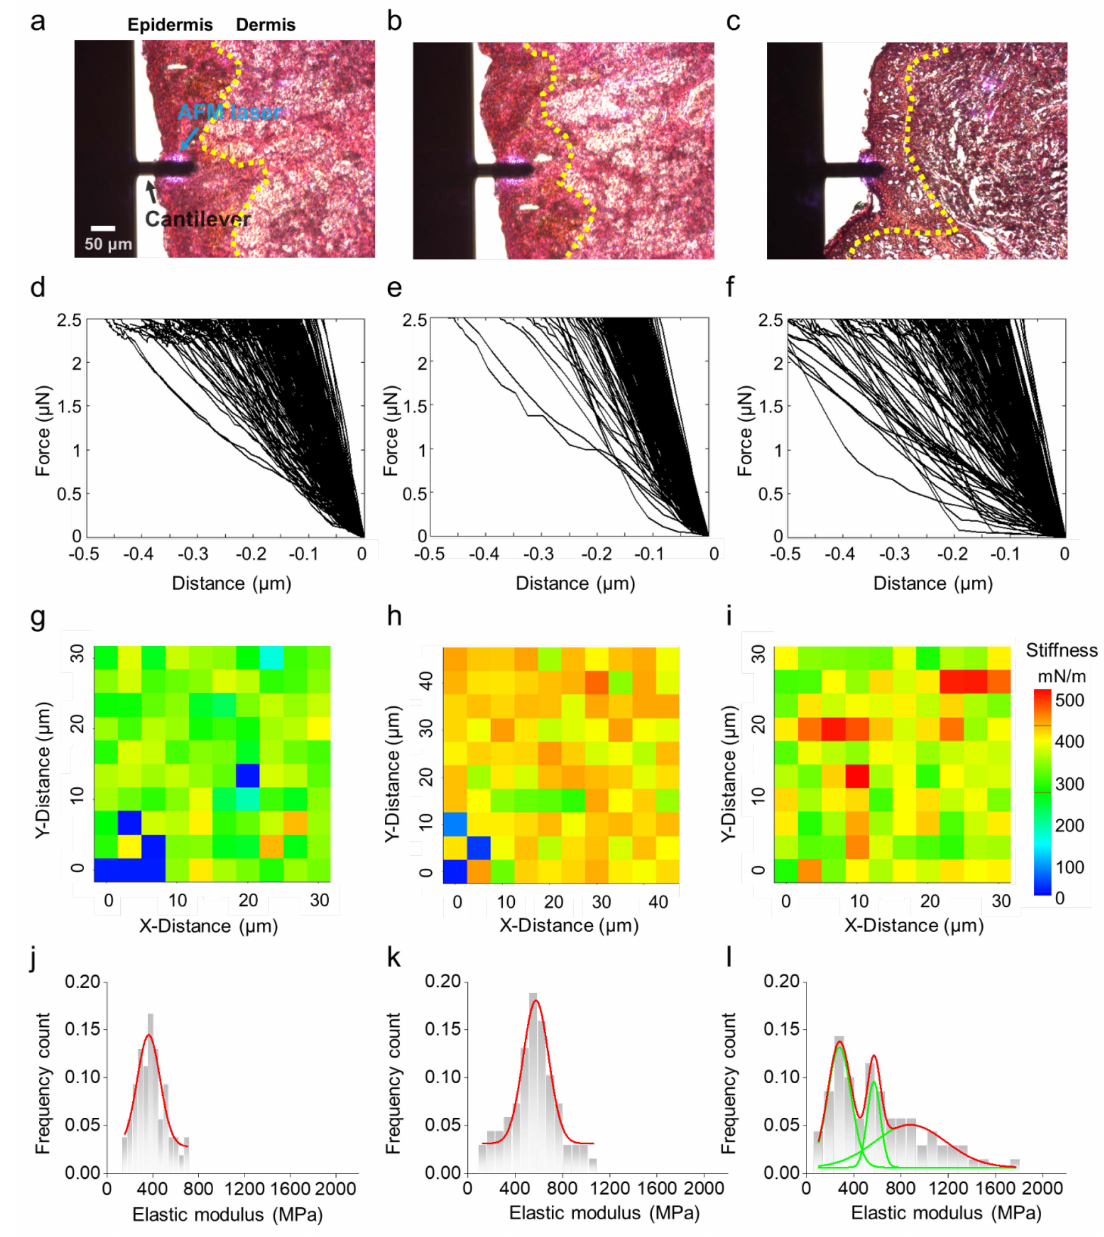
Figure 3. Optical images of the AFM cantilever moved above the tissue on ( a ) normal, ( b ) benign nevus, and ( c ) melanoma specimens. The yellow dotted line indicates a basal layer between the epidermis and dermis. ( d – f ) FD curve and representative stiffness maps (10 × 10 points) across the ( g ) normal, ( h ) benign nevus, and ( i ) melanoma specimens. ( j – l ) Corresponding histogram of elastic modulus distribution, which was calculated from the FD curve